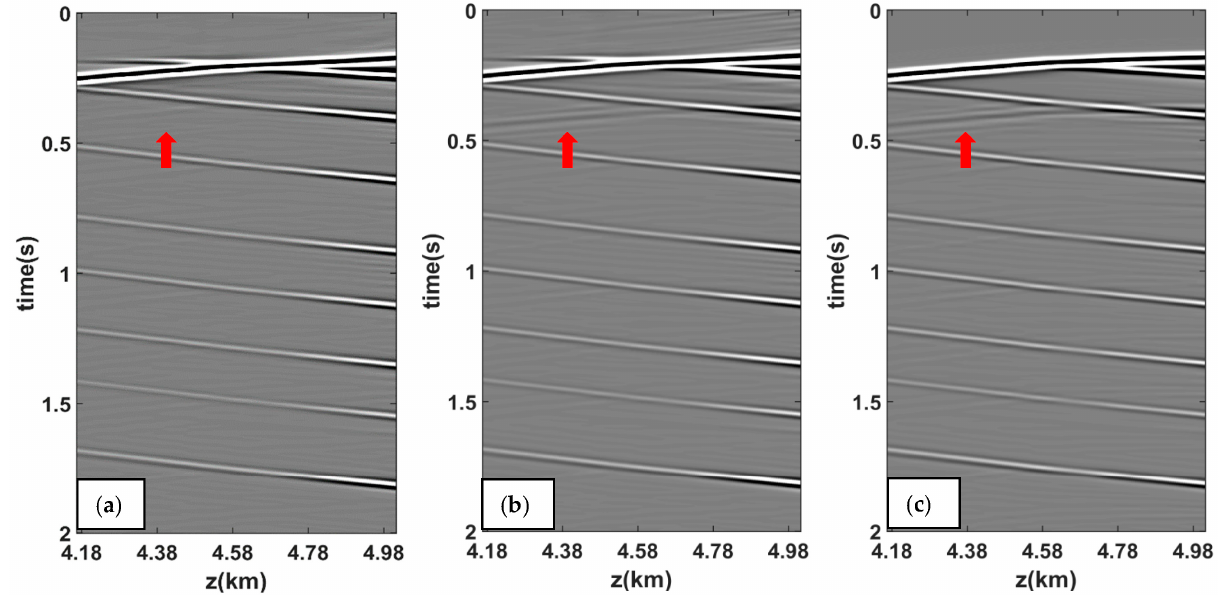
Figure 5. A comparison of wavefields of the retrieved Green’s functions between a virtual source (X: 2500 m; Z: 5040 m) and virtual receivers (X: 3500 m; Z: 4170–5020 m) based on different methods. ( a ) The estimated wavefield using the standard Marchenko source-receiver redatuming. ( b ) The estimated wavefield using the Marchenko source-receiver redatuming with VSP data. ( c ) The waveform modeling result based on the true model.